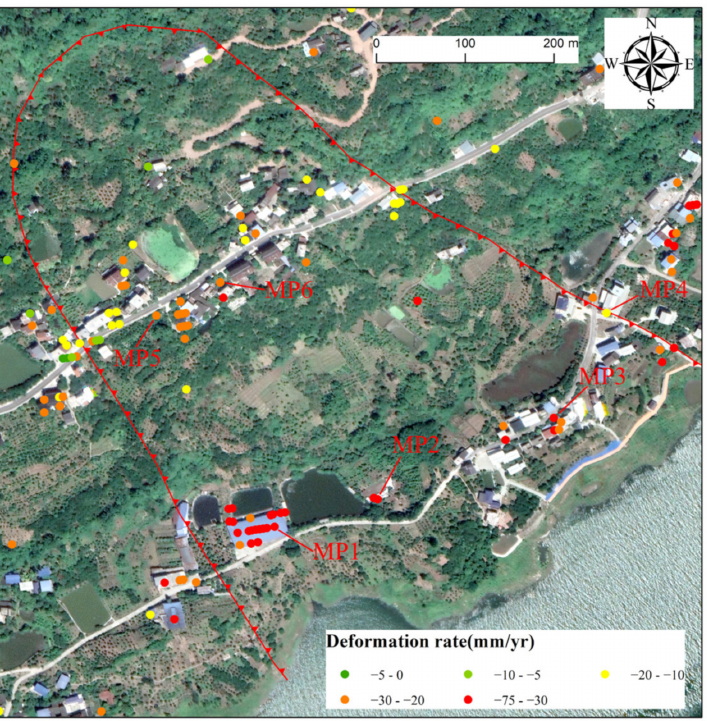
Figure 8. Spatial distribution of InSAR measurement points of the Sifangbei landslide and its deformation